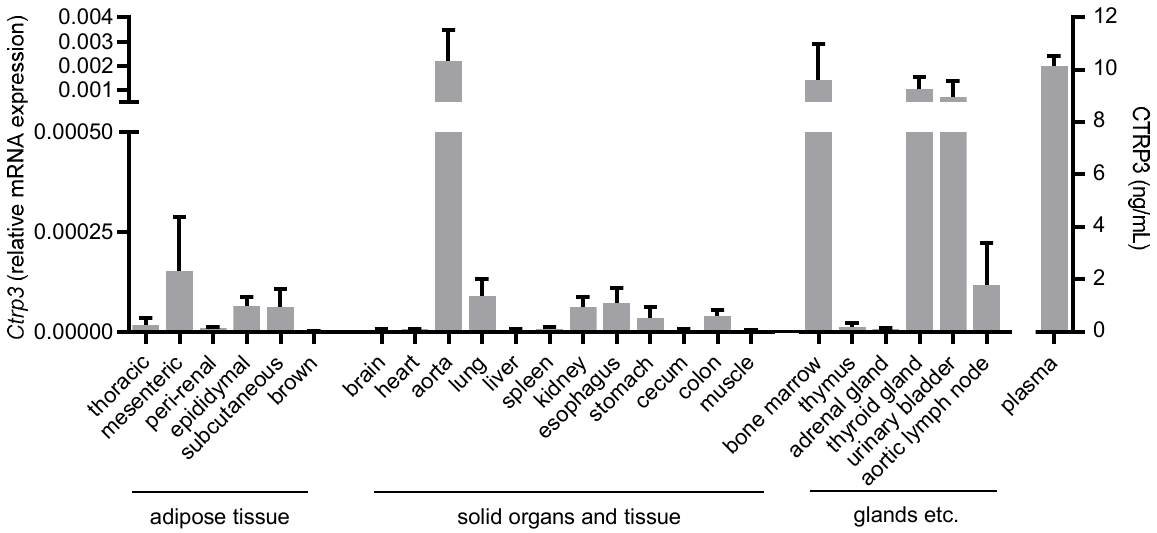
Figure 1. Tissue expression of Ctrp3. Ctrp3 (C1q/TNF-related protein 3) mRNA levels in different murine tissues and organs were determined by Real-time PCR and CTRP3 serum level by ELISA. n = 4–6 mice.